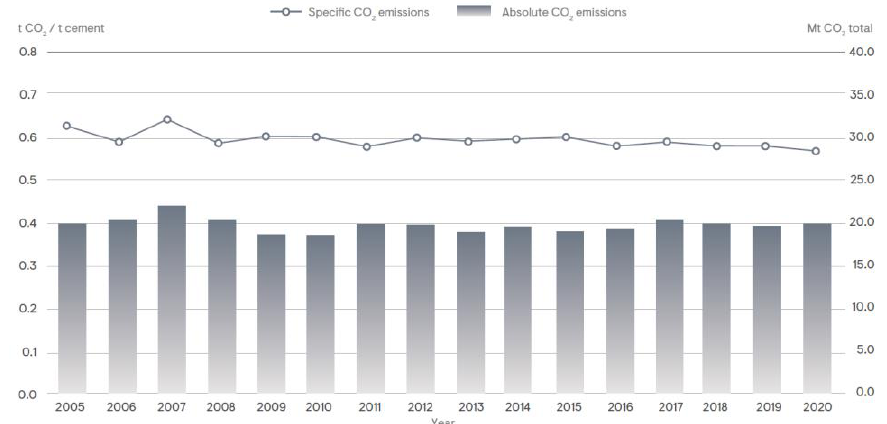
Figure 2. Direct CO 2 emissions from the German cement industry (raw material and energy-related CO 2 emissions excluding electricity generation) [22]. CO 2 emissions excluding electricity generation)